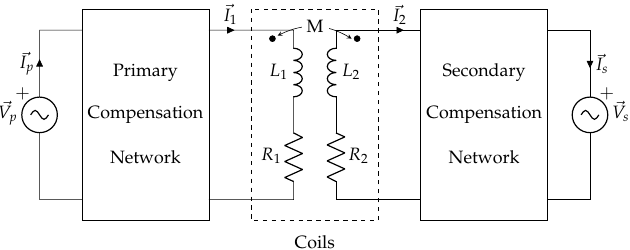
Figure 4. The simplified circuit of an EV bidirectional wireless